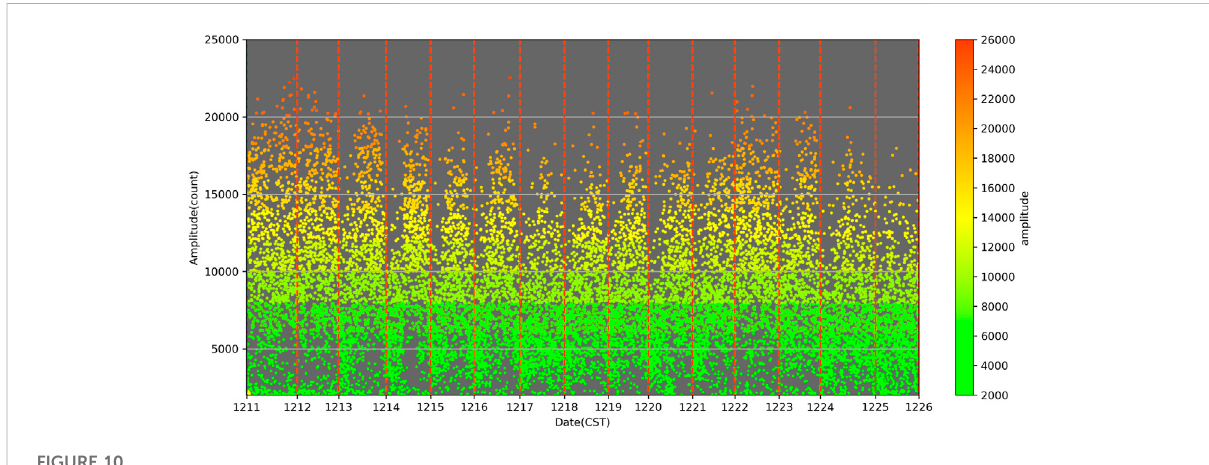
FIGURE 10 Passing vehicles ’ amplitudes over the time.